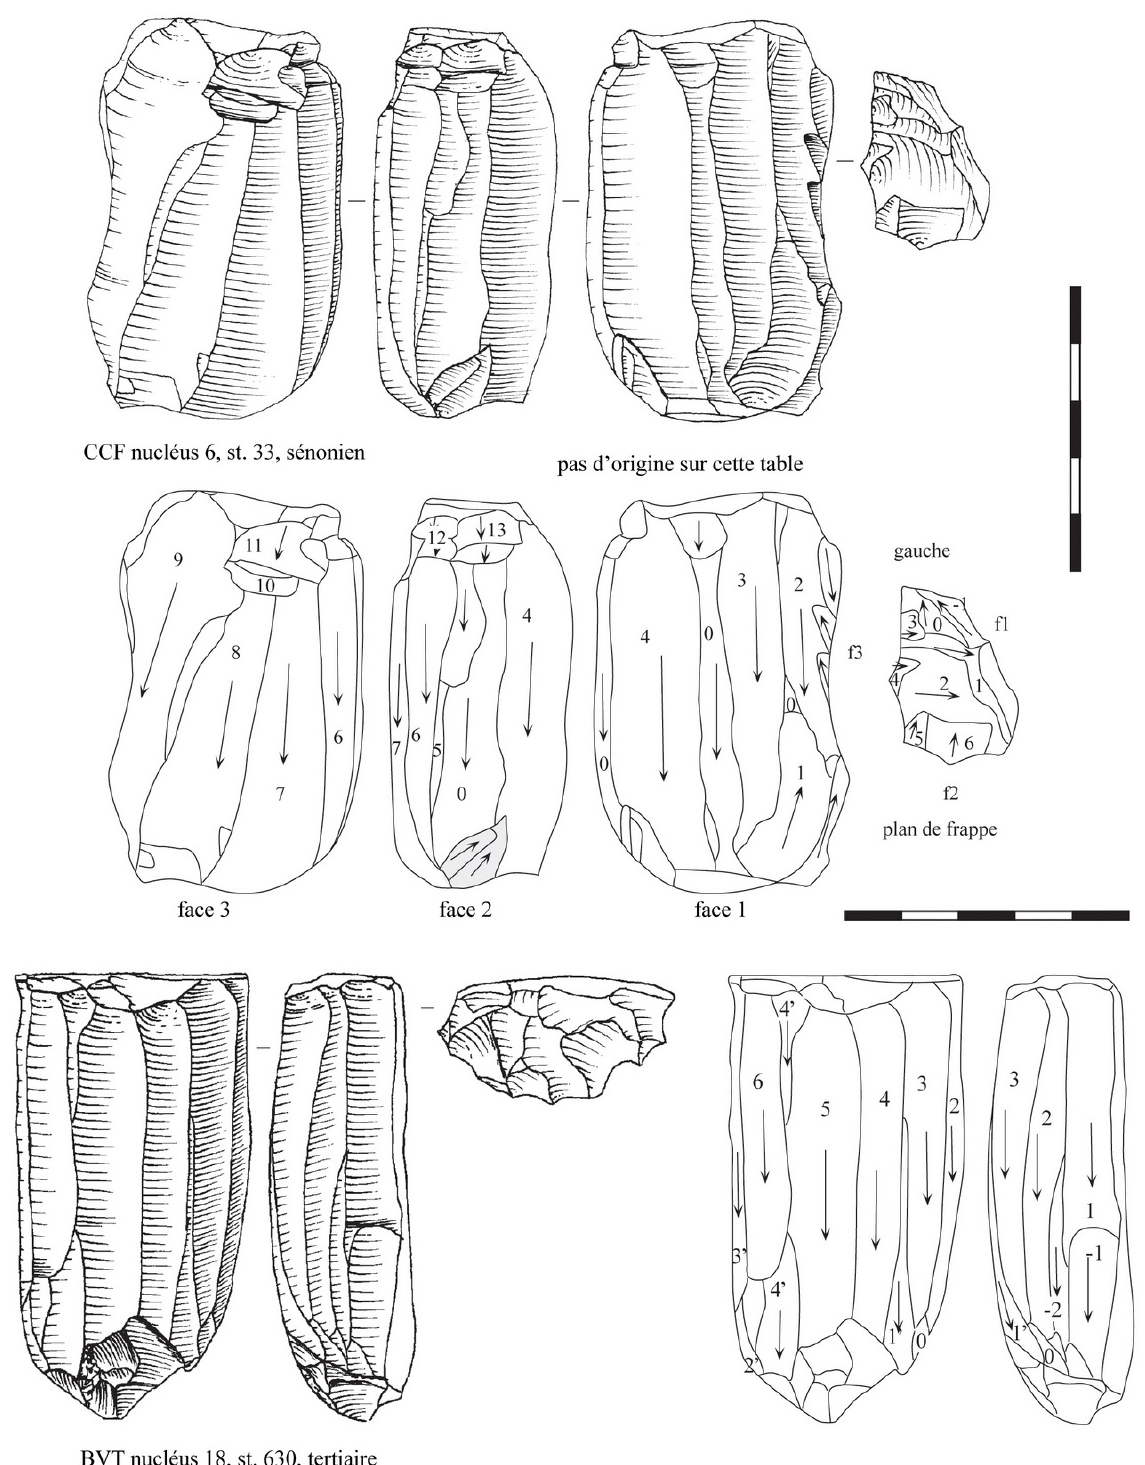
Figure 12. Nucléus du Néolithique ancien (Rubané récent du Bassin de la Seine) de Cuiry-lès-Chaudares « les Fontinettes » et de Berry-au-Bac « Le vieux Tordoir » (Allard 2005). (L’échelle est de 5 cm divisée en segments de 1 cm.) Figure 12. Blade core of the Early Neolithic (Linearbandceramic of the Seine Basin) of Cuiry-lès-Chaudares "Les Fontinettes" and Berry-au-Bac "The Vieux Tordoir" (Allard 2005). (Scale bars are 5 cm wide, divided into 1 cm